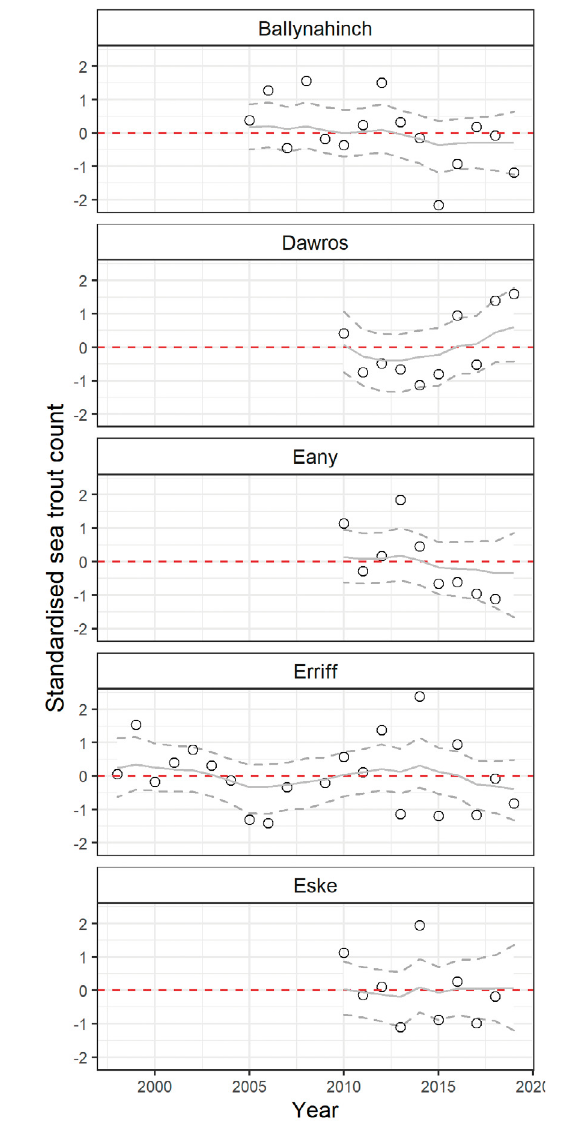
Fig. 5. Standardised annual number of sea trout returning to each of the study rivers, with a fitted random walk smoother with 95% credible intervals. Red dashed horizontal zero line represents the mean standardised annual return to each